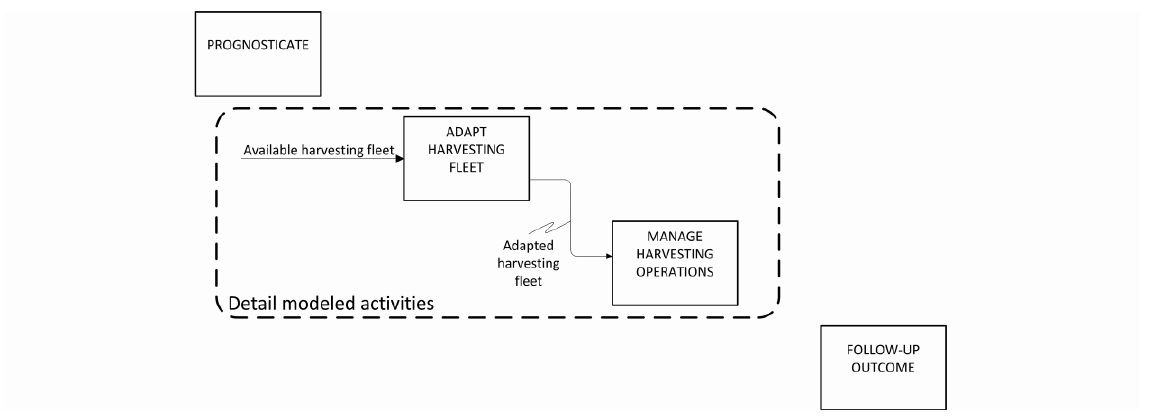
Figure 8. Activities in the Harvest wood function. The dashed square marks activities that were modeled in further